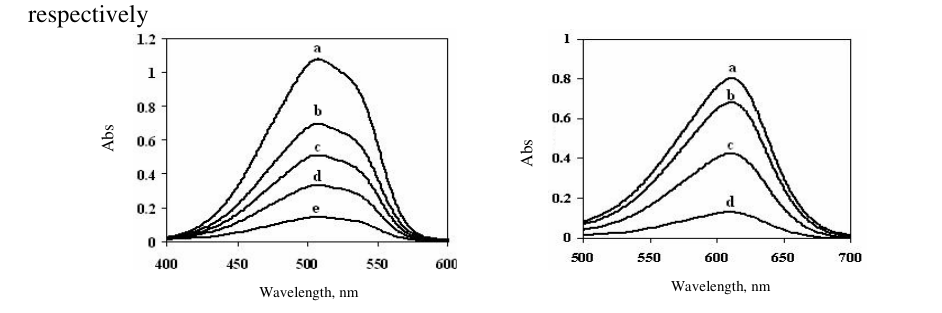
Figure 4 . (a) Blank (without STS) (b) 10.0 µ g mL -1 (c) 6.0 µ g mL -1 (d) 2.0 µ g mL -1 measured against